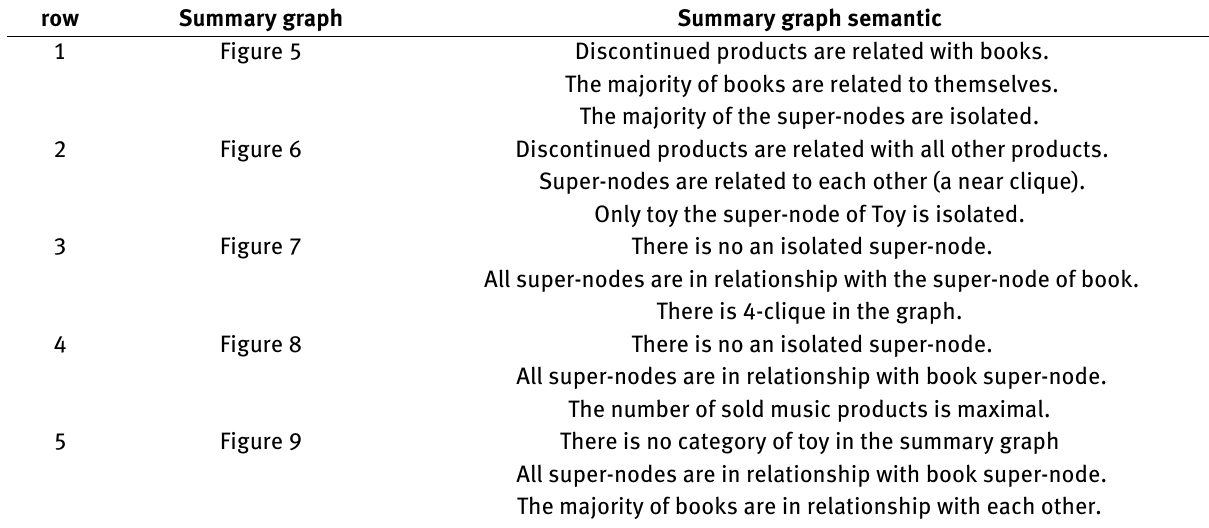
Table 3: semantic of the summary graphs row Summary graph